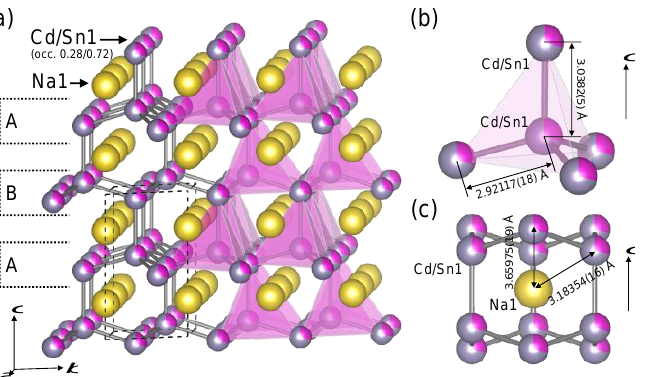
Figure 3. Crystal structure of Na(Cd 0.28 Sn 0.72 ) 2 : a general view ( a ), a Cd/Sn1 tetrahedron ( b ), and an arrangement of Cd/Sn1 around Na1 ( c ).